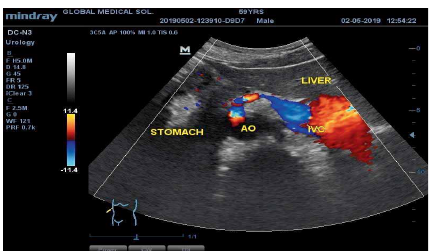
Figure 3: Colour Doppler ultrasound image of the epigastrium in transverse plane. This demonstrates a right-sided abdominal aorta (AO) and left sided inferior vena cava (IVC). Also showing a right- sided stomach and a left-sided liver, which is the reverse of their normal anatomical positions.